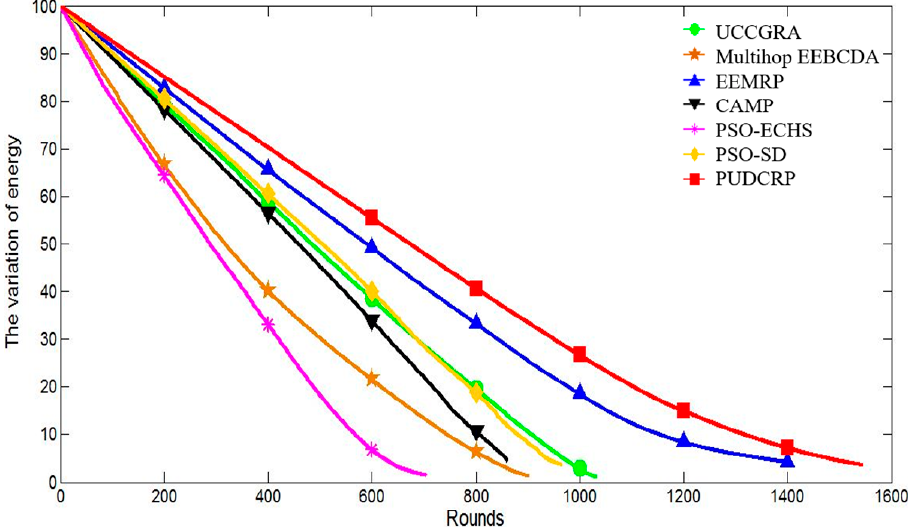
Figure 17. Energy consumption of the 400 m × 400 m network area.